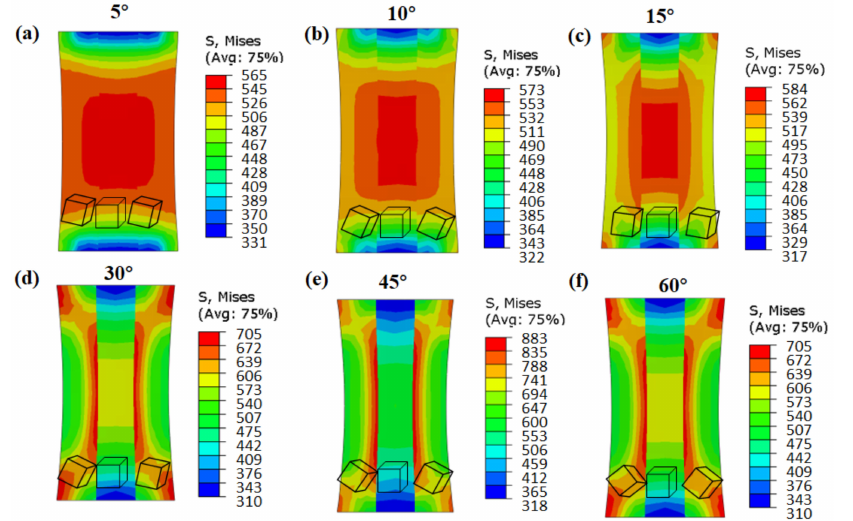
Figure 7. CPFEM simulation results of effective stress for columnar grains with different misorienta- tion angles: ( a ) 5 ◦ , ( b ) 10 ◦ , ( c ) 15 ◦ , ( d ) 30 ◦ , ( e ) 45 ◦ , and ( f ) 60 ◦ .